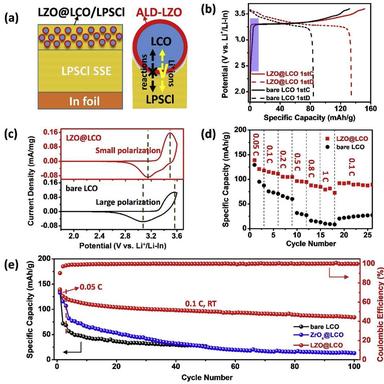
(a) A schematic diagram of the In//LPSCl//LZO@LCO/LPSCl all-solid-state battery and the proposed mechanism; (b) charge and discharge curves (0.025 C); (c) the first-cycle CV results at a scan rate of 0.1 mV/s; (d) rate capability and (e) long-term cycling stability of all-solid-state batteries with bare LCO, ZrOx@LCO, and LZO@LCO cathodes. All electrochemical performances were obtained at room temperature (RT).